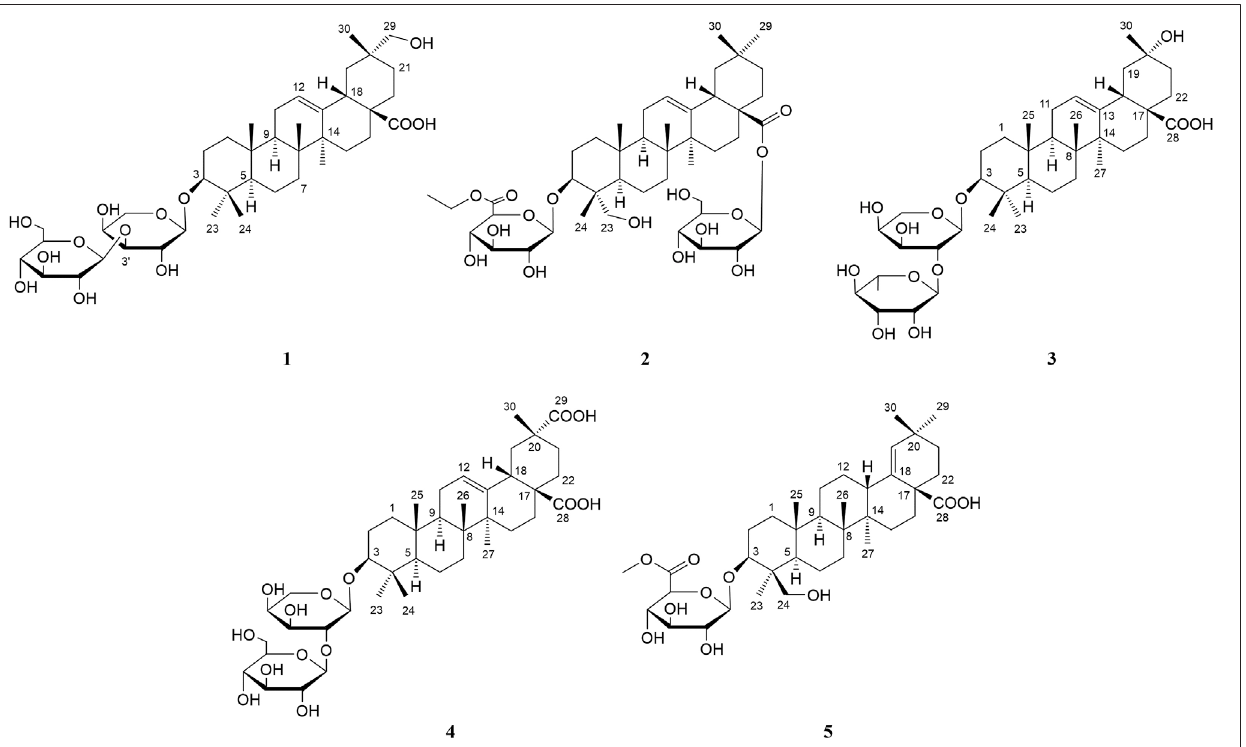
FIGURE 1 | Chemical structures of compounds 1 – 5